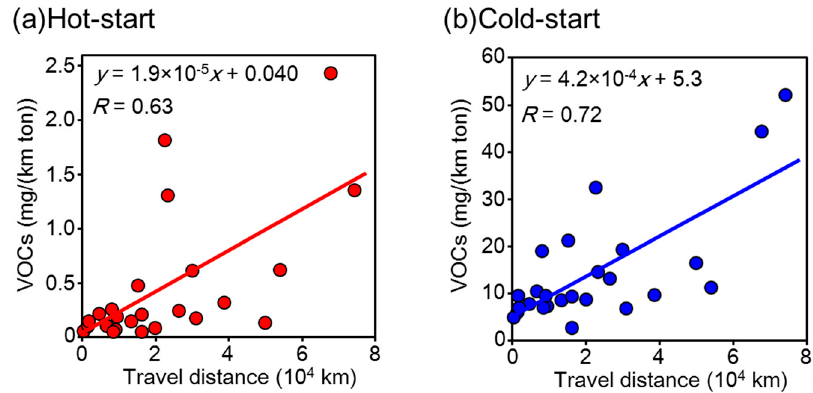
Figure 3. Relationship between mileage and total VOC emissions from the 25 vehicles observed in this study following a ( a ) hot-start and ( b ) cold-start.